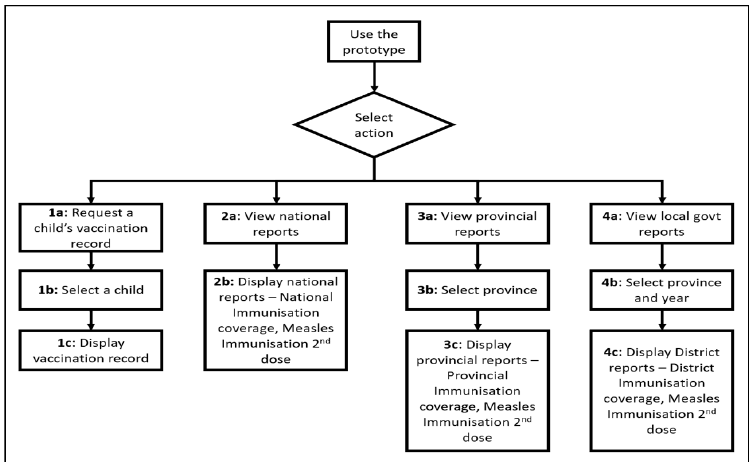
Figure 6: Process flows for school